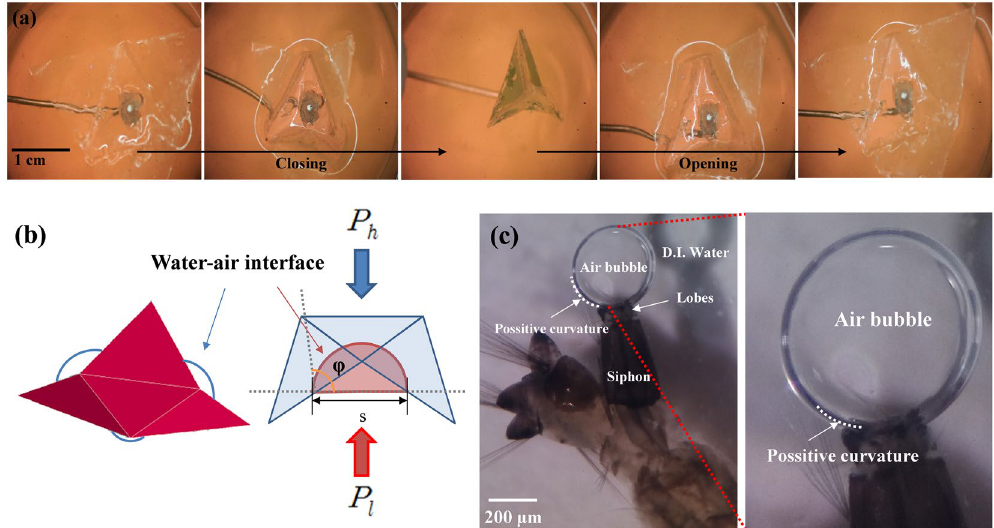
Figure 4. The opening and closing mechanism of the siphon model. ( a ) Five consecutive images of the siphon model moving near the water-air interface. ( b ) Schematic illustration of the force balance between hydrostatic pressure ( P h ) and Laplace pressure ( P l ) . ( c ) Wettability of the siphon, especially the lobes part, after dying with surfactant. The white dashed line represents a positive curvature of gas bubble released from the